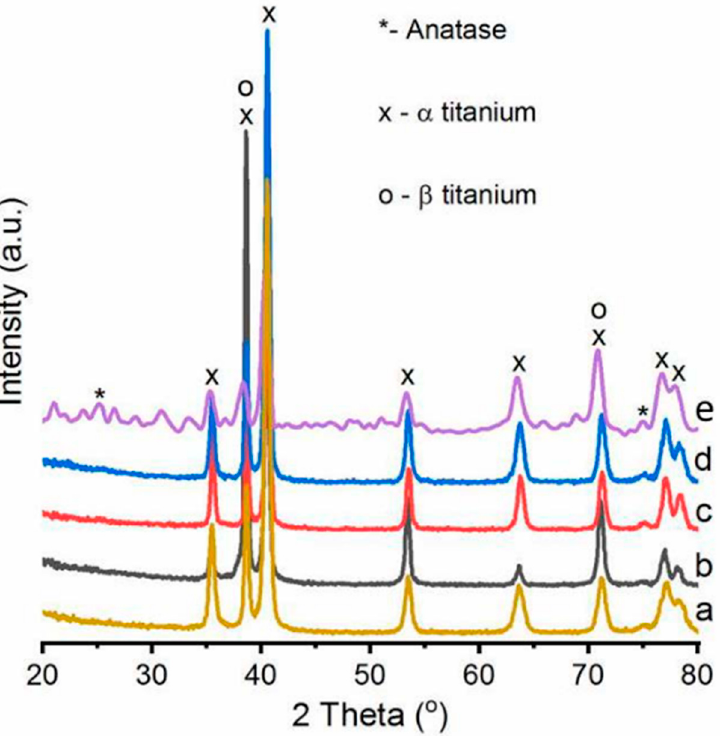
Figure 3. XRD spectra of AECT and SLM interfaces: ( a ) SLM, ( b ) AECT-1, ( c ) AECT-2, ( d ) AECT-3, and ( e ) AECT-4. Reprinted with permission from [42]. Copyright 2021 MDPI. Distributed under Creative Commons Attribution-based license (CCBY 4.0.).